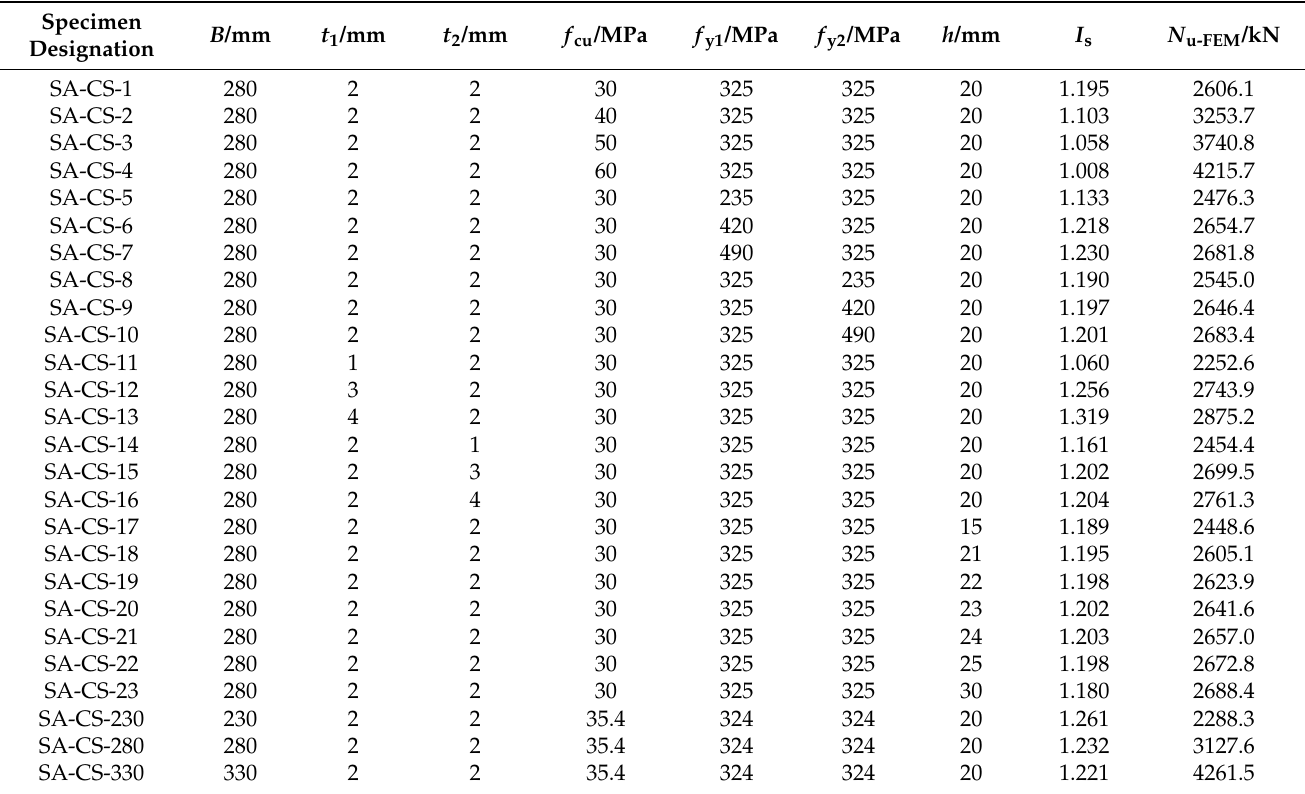
Table 3. Specific parameters and results of models.